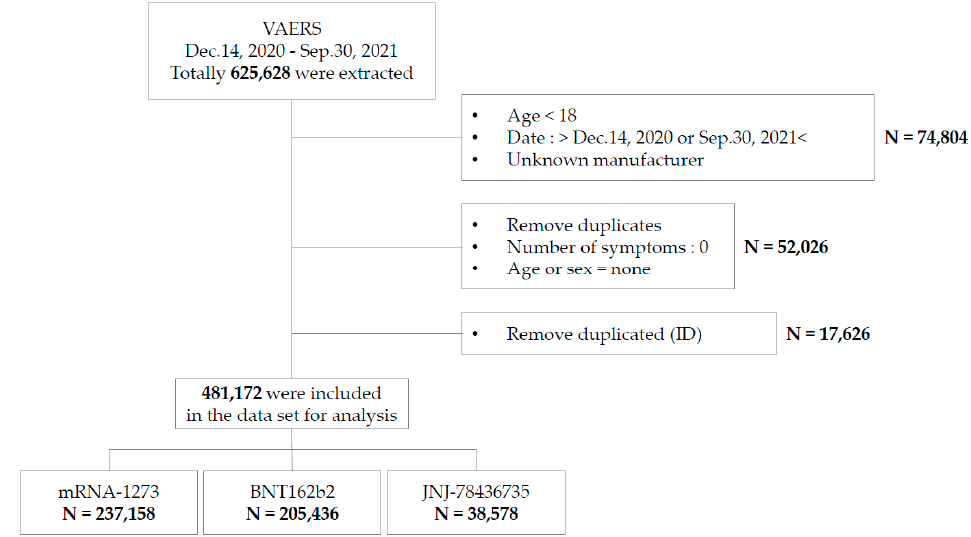
Figure 1. Workflow of this